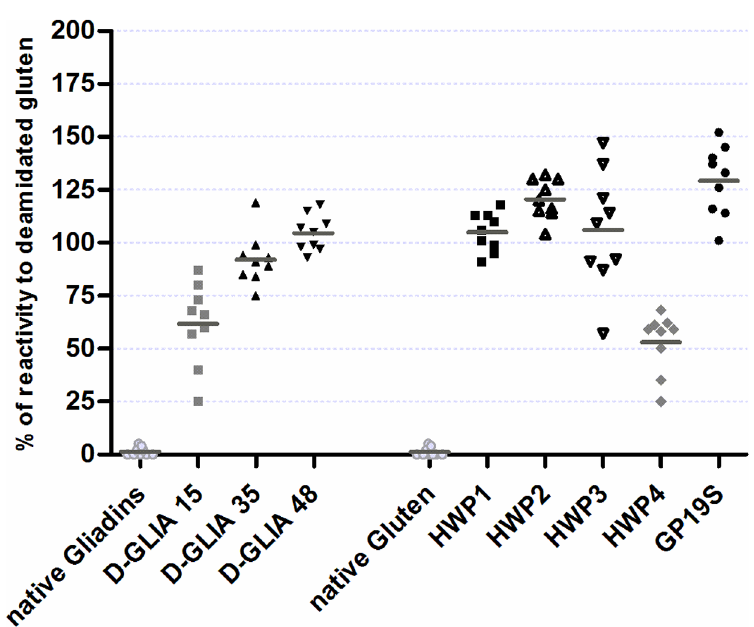
Fig 1. Reactivity of patient IgEs to deamidated wheat proteins with different deamidation levels. Concentrations of patients’specific IgEs for native gliadins,native gluten, deamidated gliadins(D-GLIA15, 35, 48), and gluten(D-Gluten), and industrialsamples of HWP (HWP1, 2, 3, 4 and GP19S) were determinedby indirectELISA. The results were normalized by determining the ratios of the specific IgE for each protein fraction to the specific IgE for D-Gluten. Symbols represent means of triplicates. Statistical analysisby Bonferroni’s multiplecomparisontest of the means of the ratios revealed3 distinct groups of samples (p < 0.001): 1) native gliadinsand native gluten(light grey symbols), 2) D-GLIA 15 and HWP4 (dark grey symbols), and 3) samples with medium and high deamidation rates: HWP1, 2 and 3 and GP19S and D-GLIA35 and 48 (black symbols). HWP, hydrolyzedwheat protein. GP19S, Glupearl 19S ® .